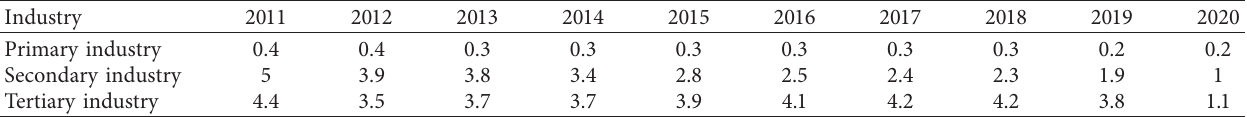
Table 5: Summary of GDP pulling ability of three major industries over the years.